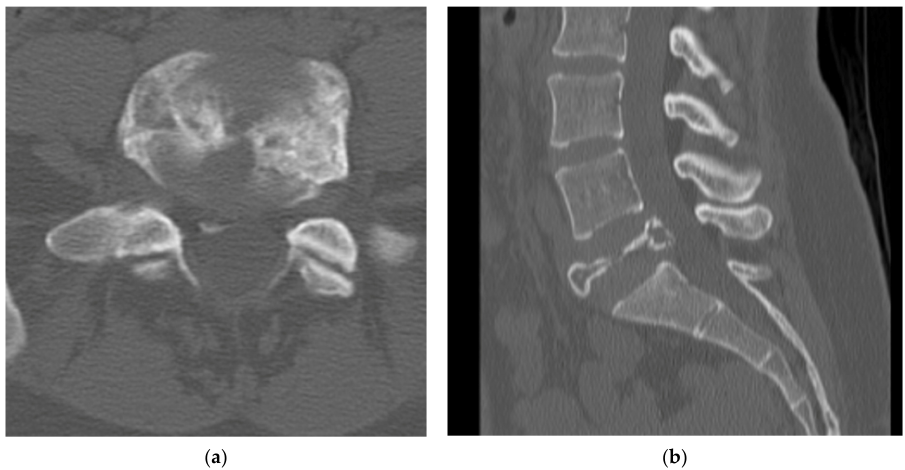
Figure 6. ( a ) L5 Giant Cell Tumor after 6 months of IV denosumab treatment. Axial cuts of L5 vertebral body show significant ossification of tumor with reestablishment of previously eroded cortices. ( b ) Sagittal cuts of L5 Giant Cell Tumor after 6 months of IV denosumab therapy show increased loss in vertebral height from previous CT scan; however, cortical margins are reestablished. There appears to be mild retropulsion of L5 vertebral body.